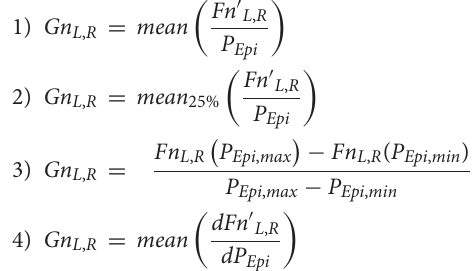
algorithm, (9) computation of additional breathing